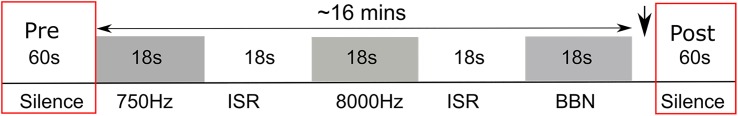
Study protocol.Schematic of block auditory testing paradigm. Participants passively listened to randomly selected pure tones (750 or 8000Hz) or broadband noise (BBN) for 18 seconds each, immediately followed or preceded by an inter-stimulus rest period (ISR) consisting of silence/absence of auditory stimulation for 18 seconds, for a total experiment run time of 18 minutes. A 60-second pre- and a separate 60-second post-stimulation paradigm baseline periods of silence were recorded from which the RSFC was derived. Black downward arrow depicts the four second wait period to allow activation levels to return to baseline.